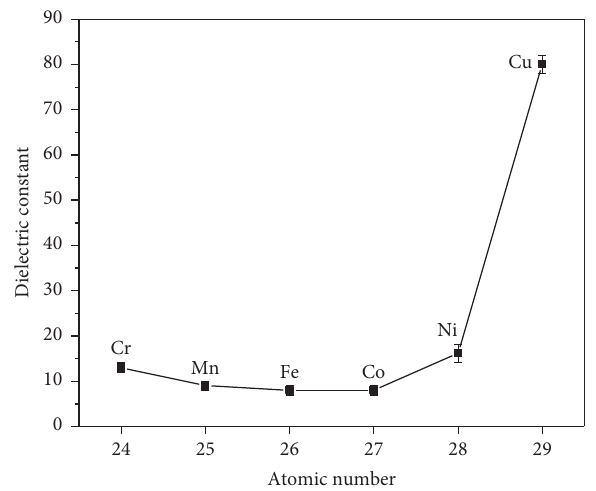
Figure 7: Variation of the dielectric constant of various transition metal-doped ZnO nanoparticles at 5% doping and at 1MHz fre- quency with respect to their atomic